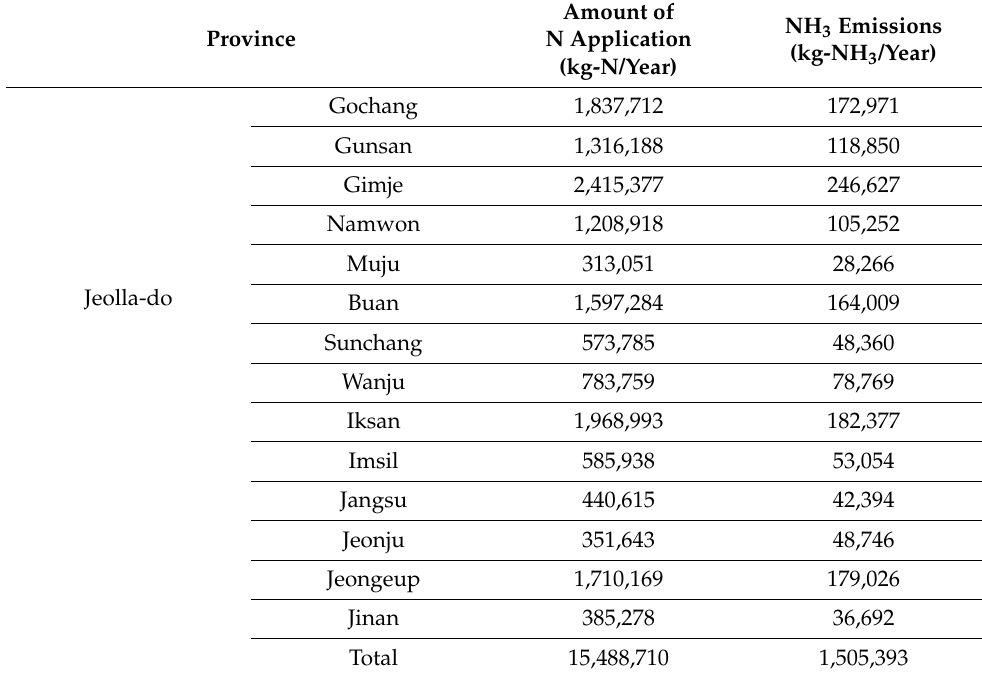
Table 9. Amount of N application and NH 3 emissions in Jeolla-do (2017) with Method III.